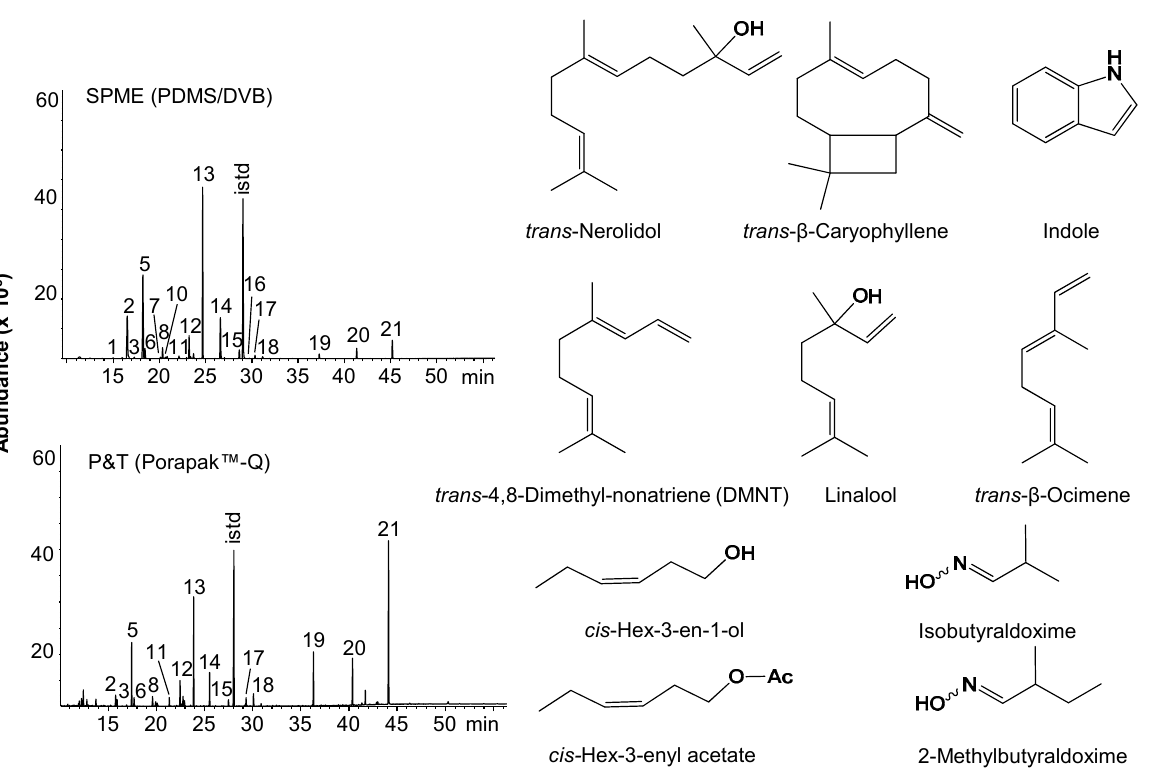
Figure 1. Chromatographic profiles of HIPVs emitted by C . nitens leaves and the chemical structure of the main volatile compounds. SPME (PDMS/DVB, 65 µ m) and P&T (Porapak™-Q) sampling. GC/MS analysis (DB-WAX column, 60 m). Table 1 contains peak identification; istd, methyl undecanoate.